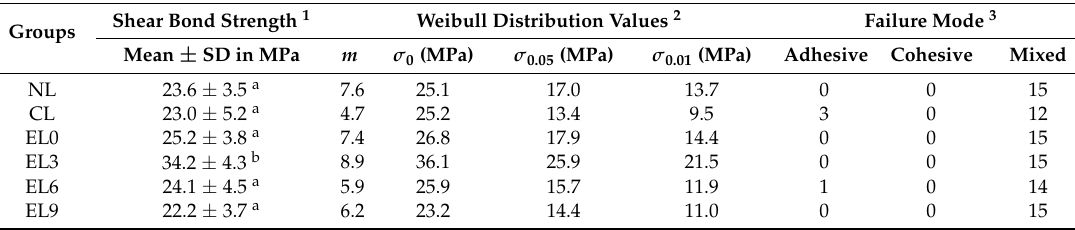
Table 2. Shear bond strength for each group ( n =